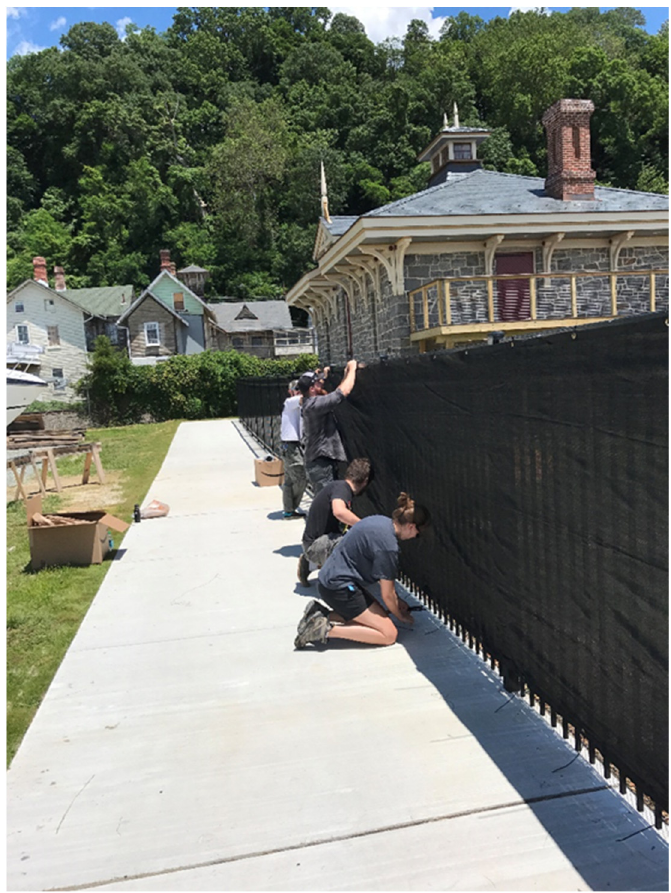
Figure 3. Wildlife exclusion fence erected around nesting grounds at the Gas House to separate nesting turtles from human disturbance.